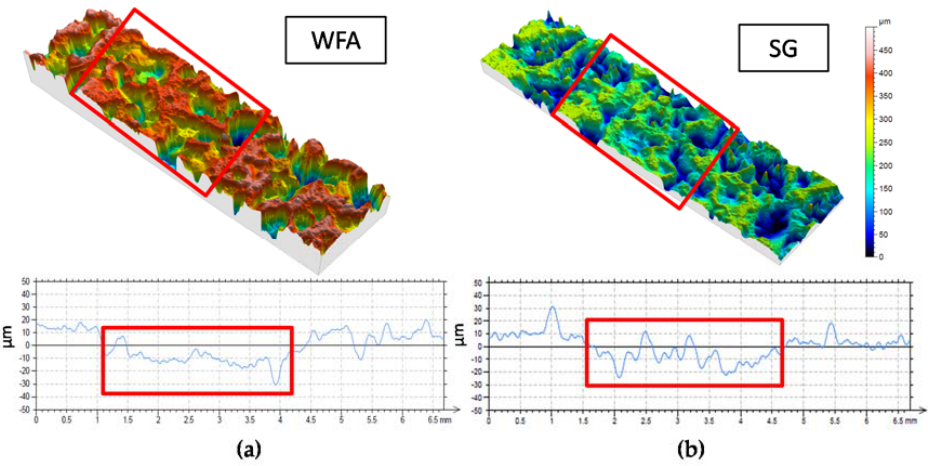
Figure 6. 3D wheel surface digitalization and envelope of filtered superimposed profiles for ( a ) WFA and ( b ) SG alumina.